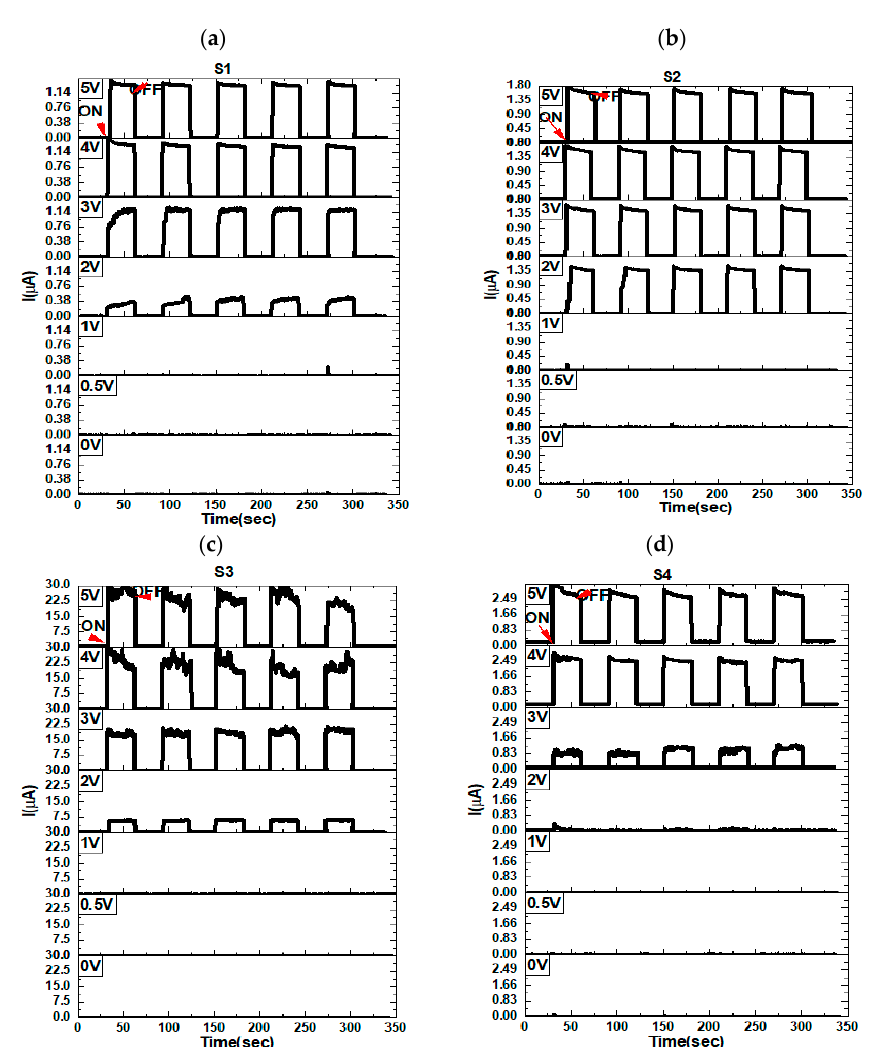
Figure 13. The photodetector ON–OFF performances with time at different applied voltage biases of 0, 0.5, 1, 2, 3, 4, and 5 V for S1 ( a ), S2 ( b ), S3 ( c ), and S4 ( d ) samples. Where ( a – d ) are deposited at 100, 150, 200, and 250 °C, respectively. All these samples were deposited in 100 pulse conditions.